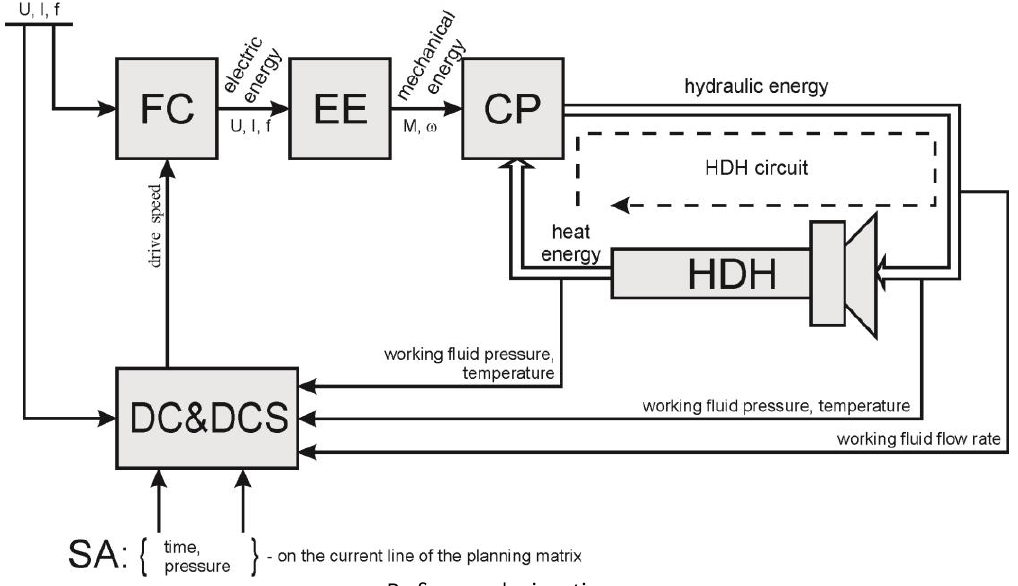
Figure 1. Functional diagram for the experimental studying of the electric technological complex of autonomous heat